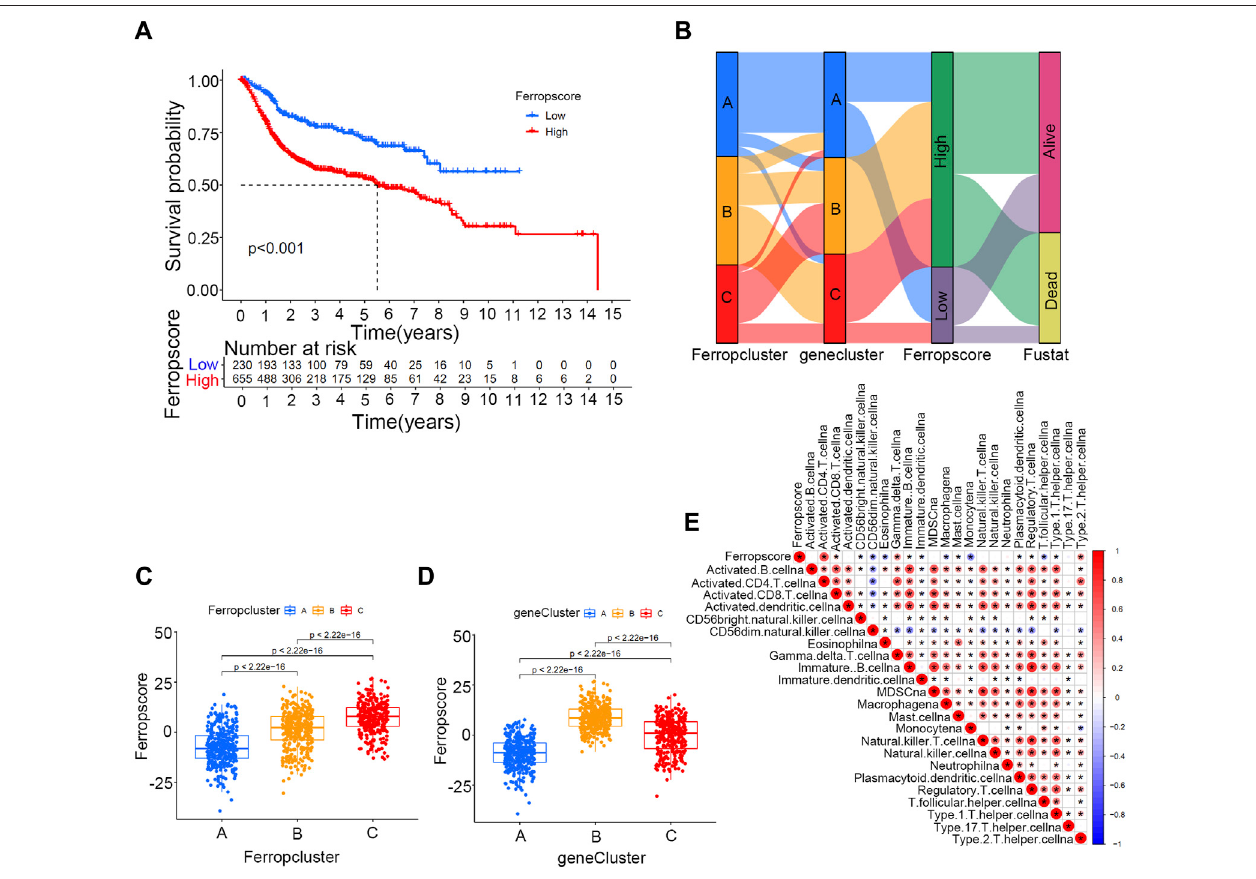
FIGURE 5 | Ferropscore as a quanti fi cation tool for individual samples in the merged cohort. (A) Kaplan – Meier curve analysis of high/low ferropscore groups. (B) Sankey diagram demonstrating correlations among ferropscore, Ferropclusters and ferroptosis gene clusters. (C) Differences in ferropscores among three Ferropclusters in the merged cohort. (D) Differences in ferropscores among three gene clusters in the merged cohort. (E) ssGSEA analysis demonstrating a correlation between ferropscore and in fi ltration abundance of various immune cells.